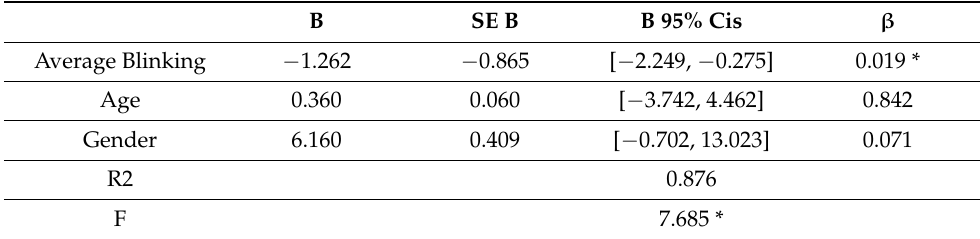
Table 6. Predictors of computer vision syndrome. B SE B B 95% Cis β Average Blinking − 1.262 − 0.865 [ − 2.249, − 0.275] 0.019 * Age 0.360 0.060 [ − 3.742, 4.462] 0.842 Gender 6.160 0.409 [ − 0.702, 13.023]